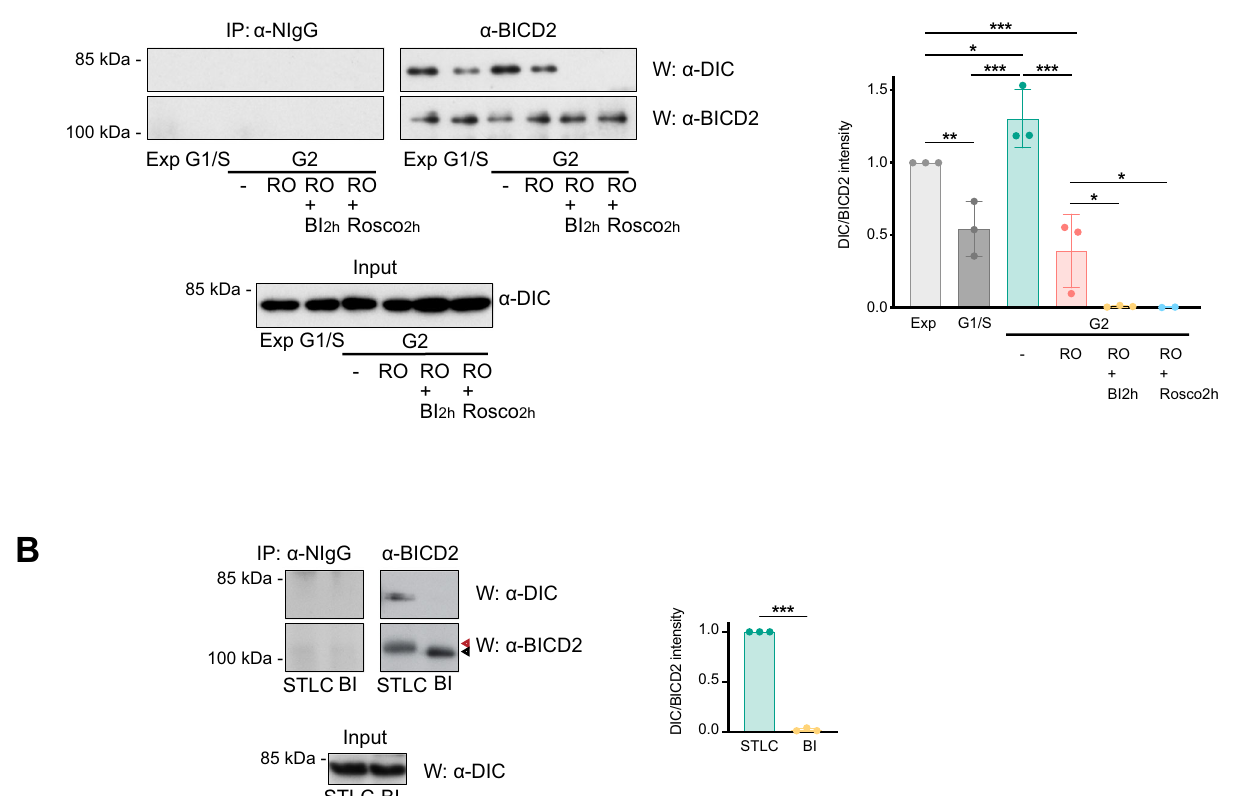
Fig. 5 | BICD2 forms a complex with dynein in G2 and M that is dependent on PLK1 activity. A PLK1 inhibition disrupts the interaction between BICD2 and dynein in G2. Normal IgG ( NIgG ) or anti-BICD2 immunoprecipitates ( IP ) from HeLa cells at different phases of the cell cycle were analyzed by western blot ( W ) using anti-DIC or anti-BICD2 antibodies. DIC levels in the corresponding extracts are showninthelowerpanel. Exp exponentiallygrowingcells, G1/S cellsarrestedatthe G1/Sborderafteradoublethymidineblock, G2 cellsinG2( - ,untreatedG2cells,8h after being released form a double thymidine block, RO RO-3306-arrested G2 cells (9M,16h); RO + BI2h RO-3306-arrestedG2cellstreatedfor2hwith100nMBI2536, RO + Rosco2h RO-3306-arrestedG2cellstreatedfor2hwith55 μ Mroscovitine).Cell cycle assignation was con fi rmed by FACS (see Supplementary Fig. S7). The mean±SD of quanti fi cations corresponding to three independent experiments (except for RO + Rosco2h , that correspond to two independent experiments ) is